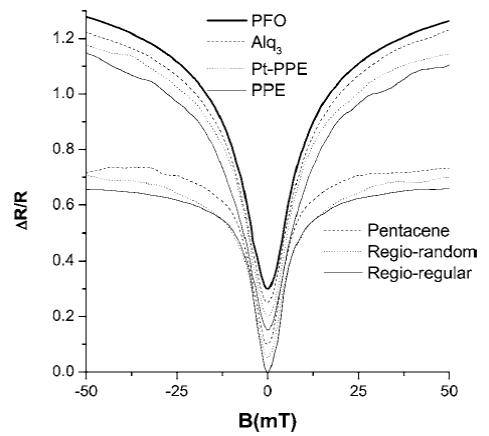
Figure 8. The fitting curve of the MR of different organic materials with the change of magnetic field by Mermer et al. [11] with the permission of Physical Review B.